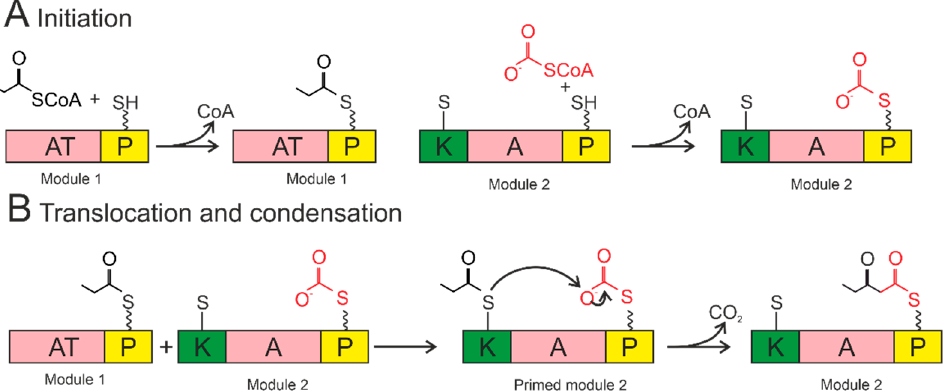
Figure 5. Siderophore biosynthesis by polyketide synthase. Acyltransferase domains load acyl groups on the P domains of Module 1. The acyl group from the loading module is transferred to the ketosynthase domain of Module 1, thereby initiating the module (bottom left). The ketosynthase domain catalyzes the condensation reaction. The growing chain is transferred to the ketosynthase domain of the next module to continue synthesis. AT—acyltransferase; P—acyl carrier protein; K—ketosynthase. The wavy line marks the post-translational modification of P pant . The short straight line in the KS domain denotes the cysteine residue of the active